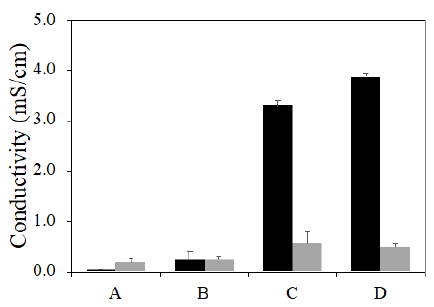
Figure 5. Conductivity of non-cross-linked (black) and cross-linked (grey) PPy–Alg thin films of composition A, B, C, and D measured via the four-point probe